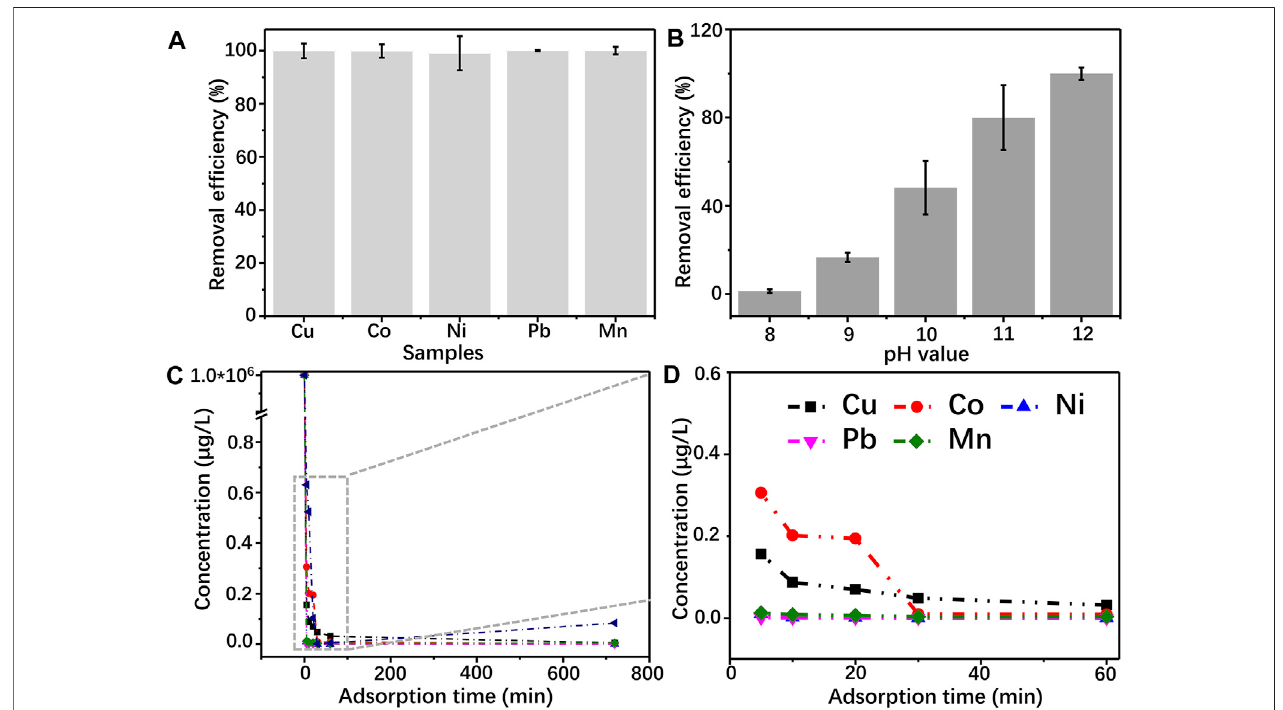
FIGURE7|(A) removalef fi cencyofCu 2+ ,Co 2+ ,Ni 2+ ,Pb 2+ ,andMn 2+ onGGhydrogel; (B) effectofpHontheadsorptionofCu 2+ byGGhydrogel (C,D) thestability testing of the GG hydrogel after adsorbing heavy metal